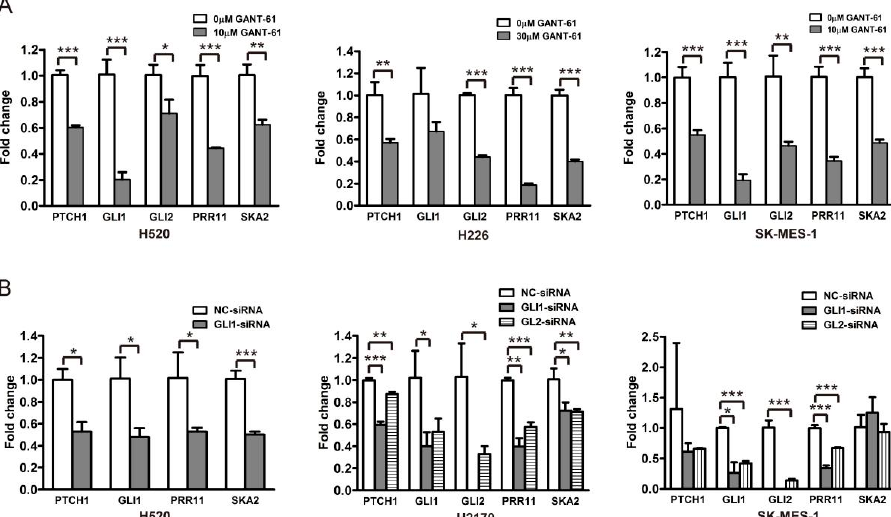
plots of gene expression levels of the Hh pathway components (SMO, GLI1, and GLI2) in normal levels of the Hh pathway components (SMO, GLI1, and GLI2) in normal tissues and tumor tissues are displayed from left to tissues and tumor tissues are displayed from left to right. Mean values are represented by horizon- right. Mean values are represented by horizontal lines (two-sided independent Student’s t -test, *** p < 0.001). tal lines (two-sided independent Student’s t -test, *** p < 0.001).